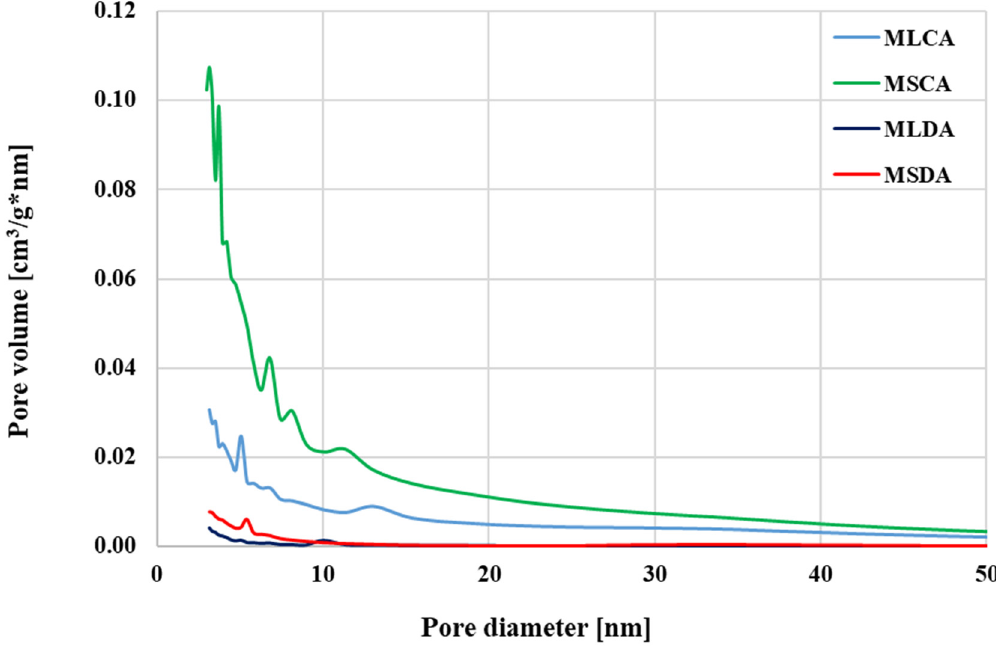
Figure 3. Pore size distribution for the activated biocarbons prepared from mugwort post-extraction residue.